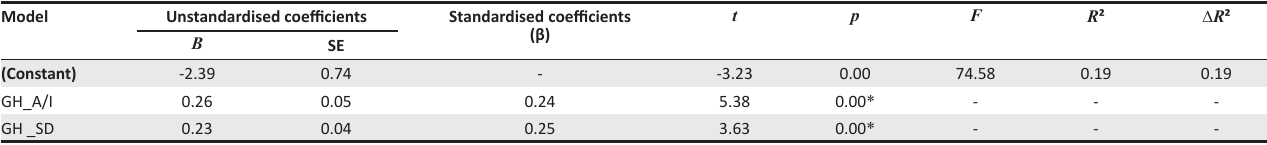
TABLE 4: Multiple regression analysis with cynicism (burnout) being the dependent variable and anxiety and insomnia and social dysfunction (general health) being the independent variables. Model